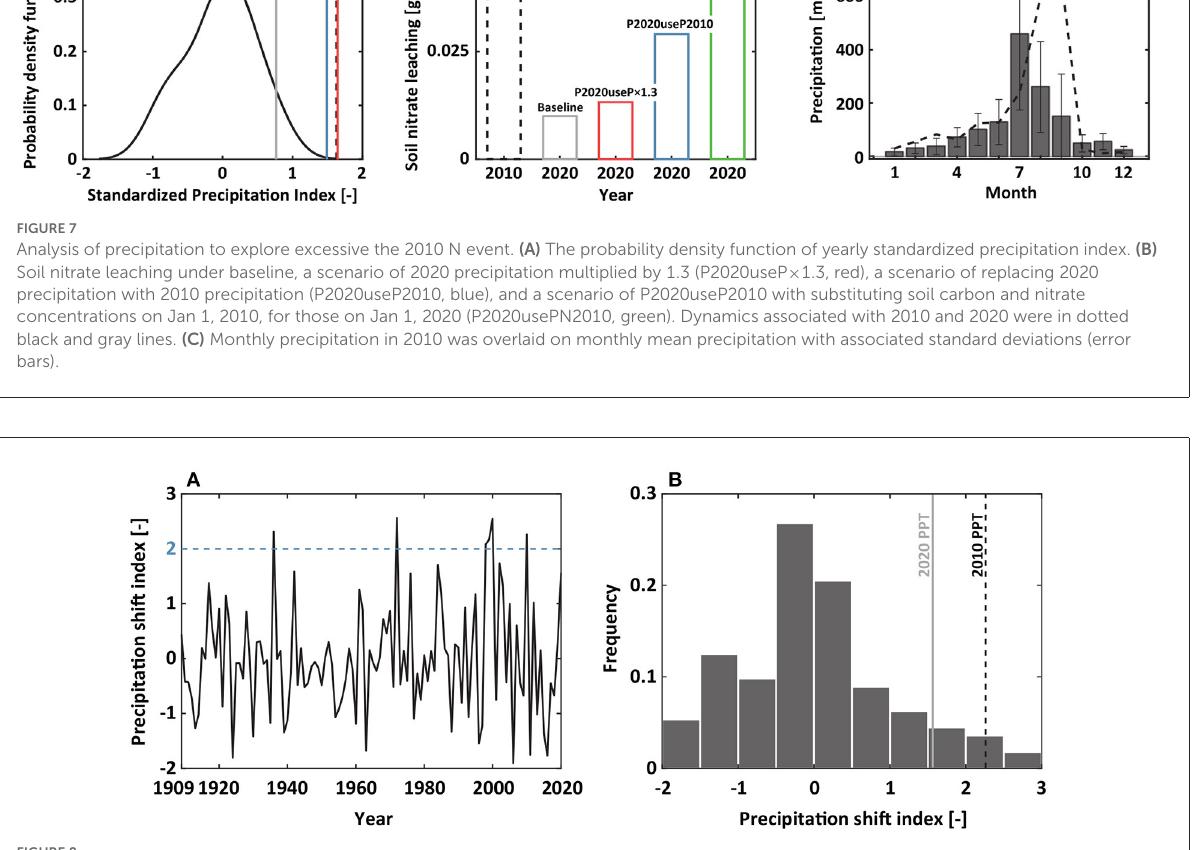
FIGURE8 To explore monthly precipitation shifts toward winter, we estimated (A) the precipitation shift index from 1909 to 2020 and (B) the frequency histogram of the precipitation shift index. The blue dotted line in (A) represents the precipitation shift index of 2. The black dotted and gray lines in (B) are for precipitation in 2010 and 2020,